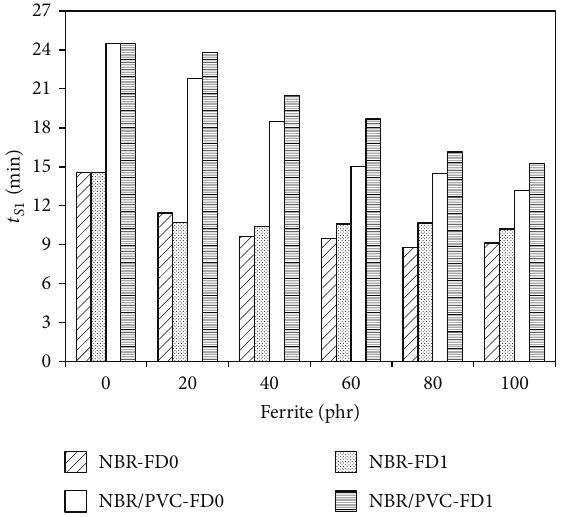
Figure 1: Influence of ferrites content on scorch time 𝑡 𝑆1 of rubber